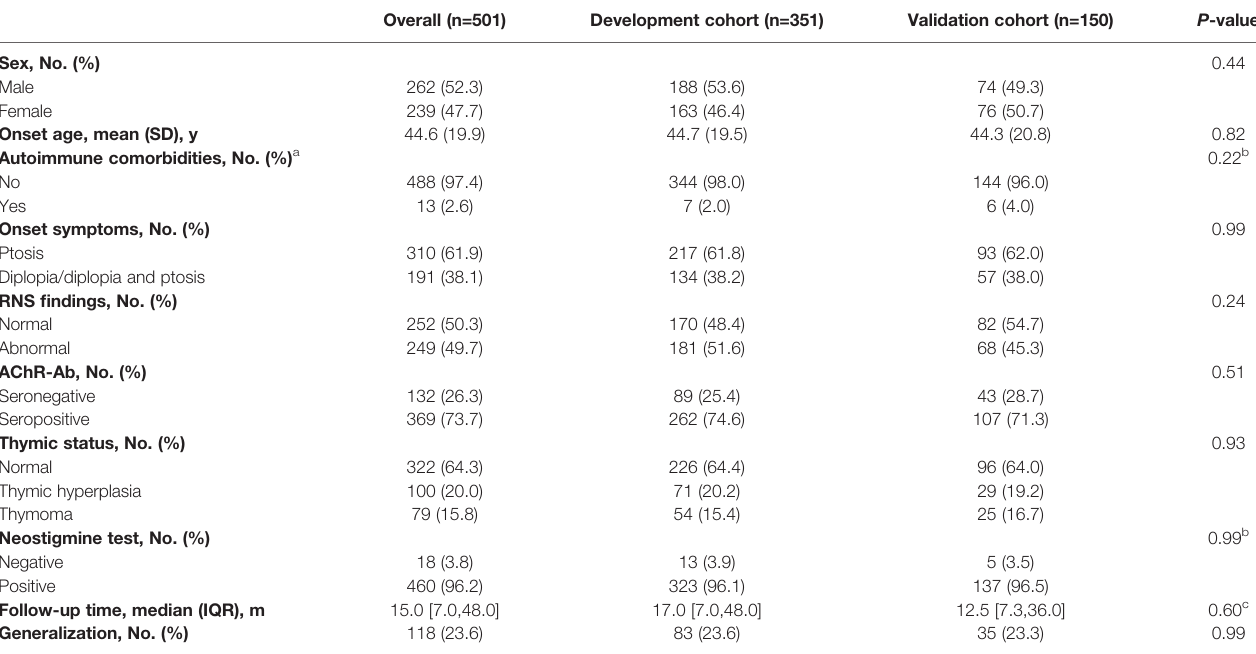
TABLE 1 | Baseline characteristics of the development and validation